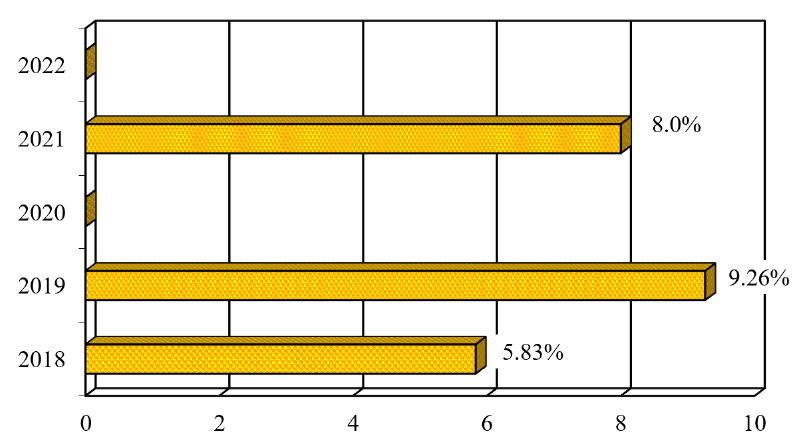
Fig. 6. Indicators of the extensiveness of trichurosis infestation of sheep in the territory of the Poltava region